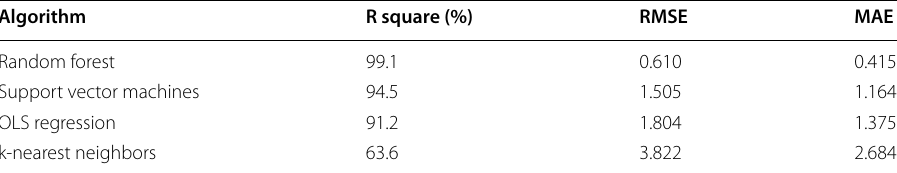
Table 2 The goodness of fit criteria of the models Algorithm R square (%) RMSE Random